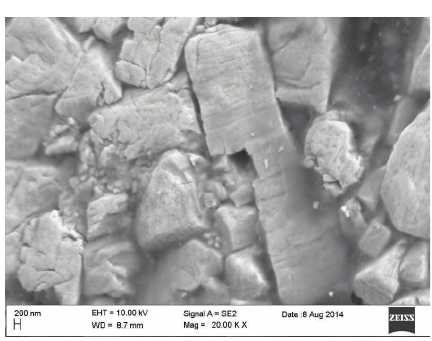
Figure 4: Crushing of WC grains; hole due to penetration of sharp edge of hard rock.